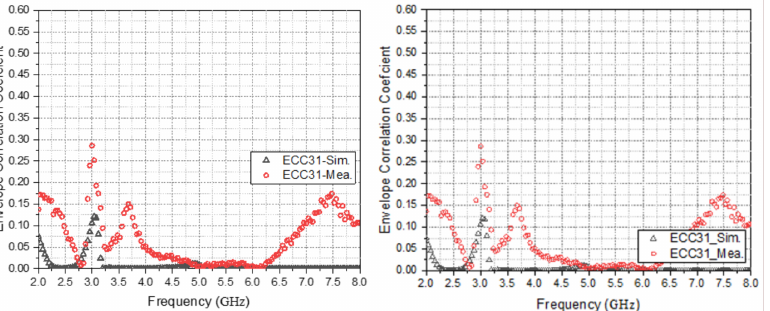
Figure 25. Comparison of ECC simulation and actual measurement between Ant. 1 and Ant. 3.